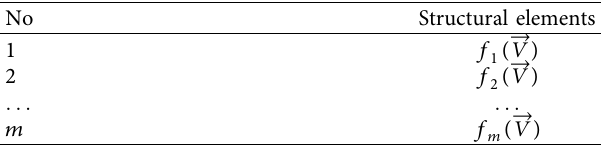
Table 1: Coding of structural elements for the model of dynamic